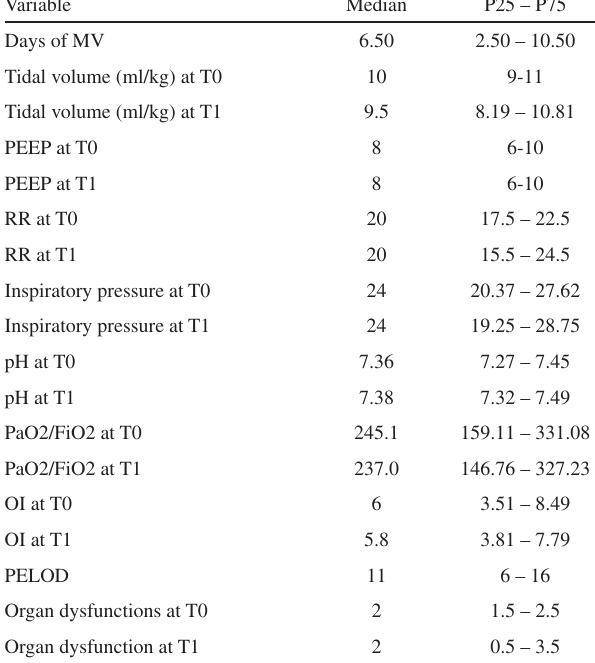
Table 1 - Ventilatory settings, arterial blood gas measure- ments and organ dysfunctions of children submitted for 24 hours of MV or more in a reference Brazilian PICU,